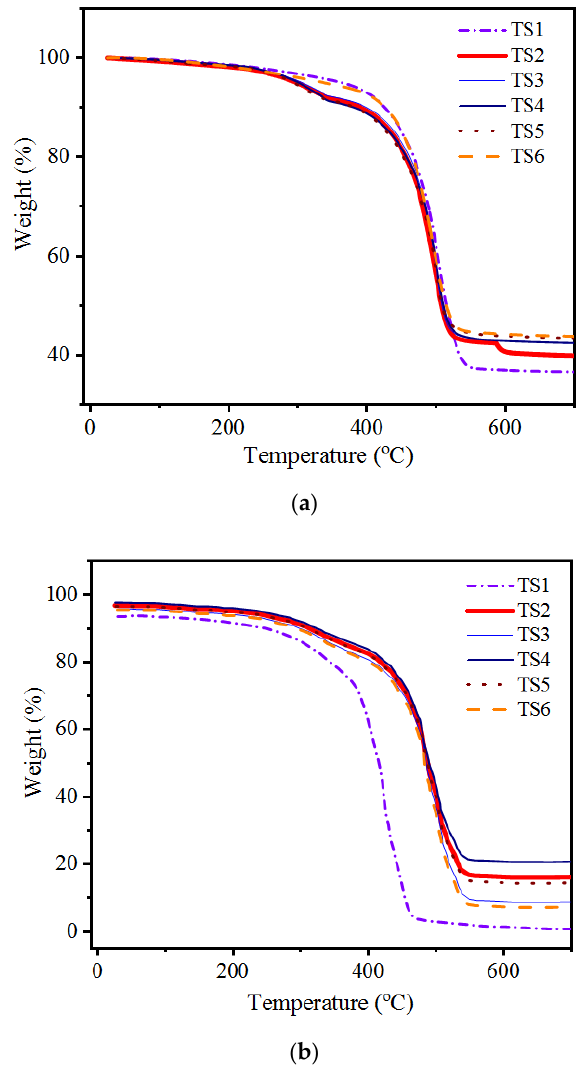
Figure 13. TGA curves of ( a ) unaged and ( b ) aged samples. Degradations of the test samples can also be co-related through the TGA curves. The thermal stability of the aged samples was inferior as compared to the unaged sample. In addition, as another indicator for estimating thermal stability, the residual weight at the final 800 ◦ C can be considered. A neat (pure SR) sample had the lowest residual weight among all other samples. The incorporation of ATH and silica results in significantly higher residual weight, particularly for the sample containing of 2% silica by weight. The residual weight of all aged specimens was found to be lower than all unaged specimens.